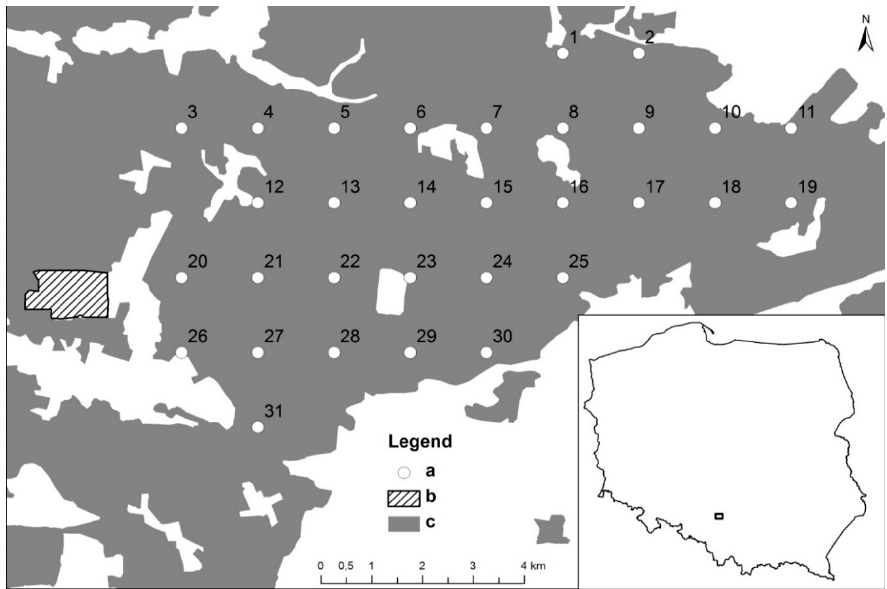
Figure 1. Location of trial plots within the Ś wierklaniec Forest District, the Brynica sub ‐ district (a—trial plots, b—zinc smelter, and c—Brynica forest sub ‐ district).